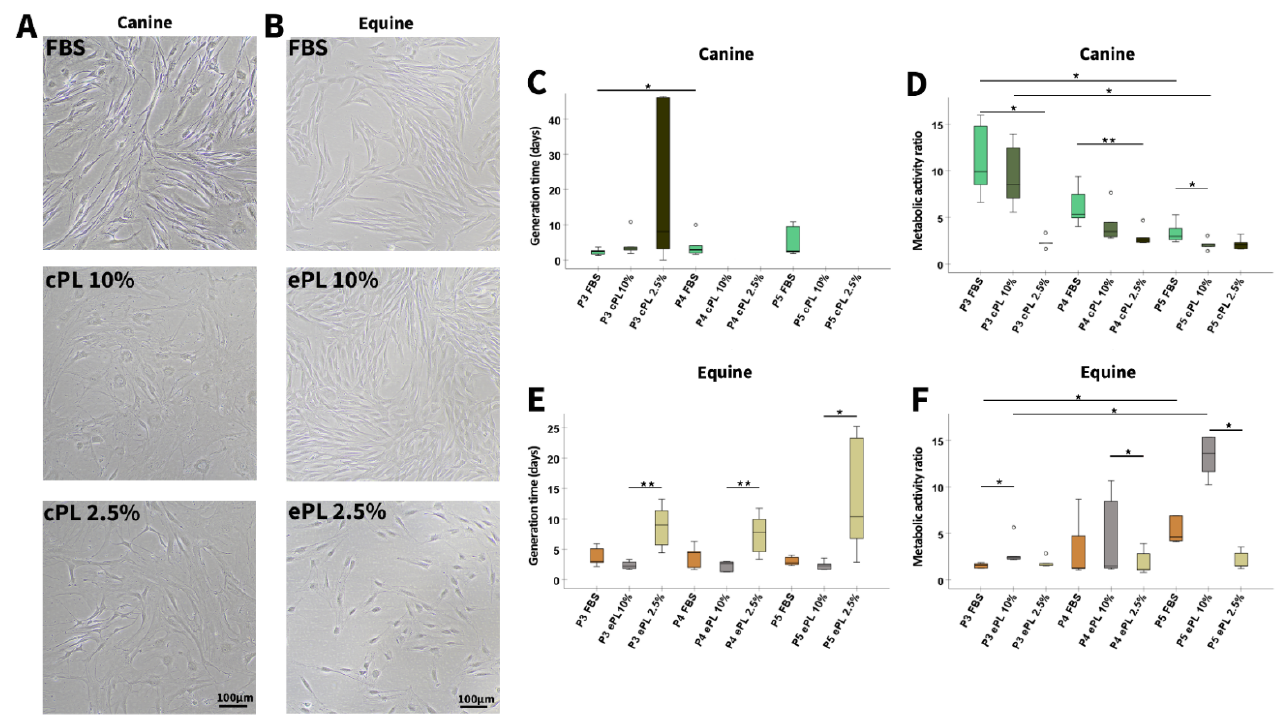
Figure 4. Mesenchymal stromal cell culture with different media supplements. Representative phase-contrast photomicrographs show canine ( A ) and equine ( B ) mesenchymal stromal cells (MSC) in passage 4 and at day 5 after seeding for population doubling assays in media supplemented with fetal bovine serum (FBS) or canine/equine platelet lysate (cPL/ePL). The boxplots display the generation times calculated for canine ( C ) and equine ( E ) MSC, as well as their metabolic activity as determined by MTS tetrazolium-based cell proliferation assay for canine ( D ) and equine ( F ) MSC in passages 3 to 5 (P3 to P5); note that missing generation time data were due to insufficient proliferation in these samples. Friedman tests for group comparisons and subsequent post hoc tests were performed; the asterisks indicate the significant differences between the corresponding groups (* corresponds to p < 0.05; ** corresponds to p < 0.01). Data were obtained using MSC from the same n = 5 donor dogs or horses in each group.